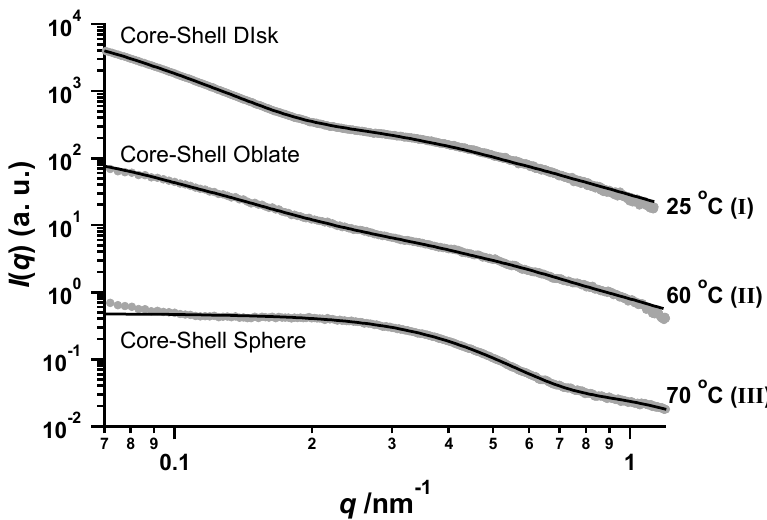
Figure 3. Fitting analyses of SAXS profiles of PVP- b -PODA micelles at 25, 60, and 70 ° C by using core-shell disk, oblate, and sphere, respectively.